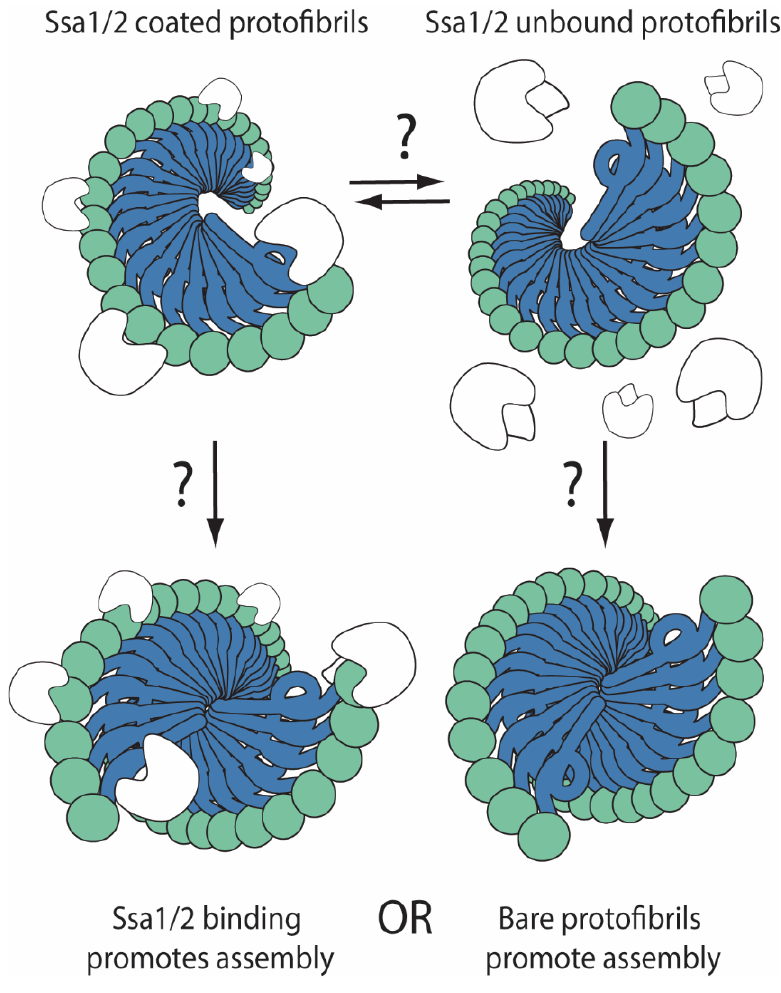
Figure 3. Is [ PSI + ] higher-order architecture controlled by chaperone binding? Hsp70 (Ssa1/2; white) appears to be associated with [ PSI + ] prion complexes (green and blue ball and corkscrew wheel stacks); however, what determines association and disassociation from these complexes or how this impacts protofibril association into higher-order fibril architectures is